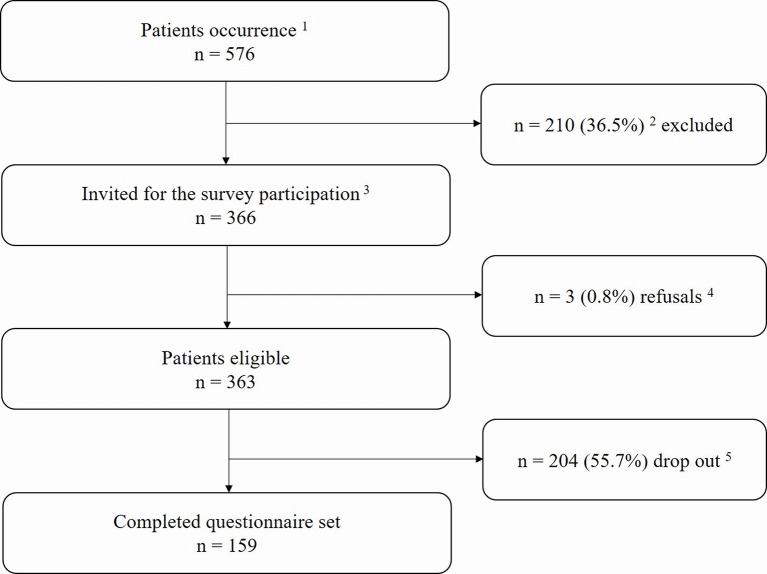
Flowchart of the study.1All patients treated within our functional gastrointestinal disorders (FGIDs) specialty care unit from January 2012 to December 2016 were screened for eligibility. 2Patients who did not meet the Rome III criteria for irritable bowel syndrome (IBS). 3The invitation period was from September 2017 to December 2017. 4Declared their refusal to participate by email or phone. 5Not available (e.g., missing contact data, did not respond).